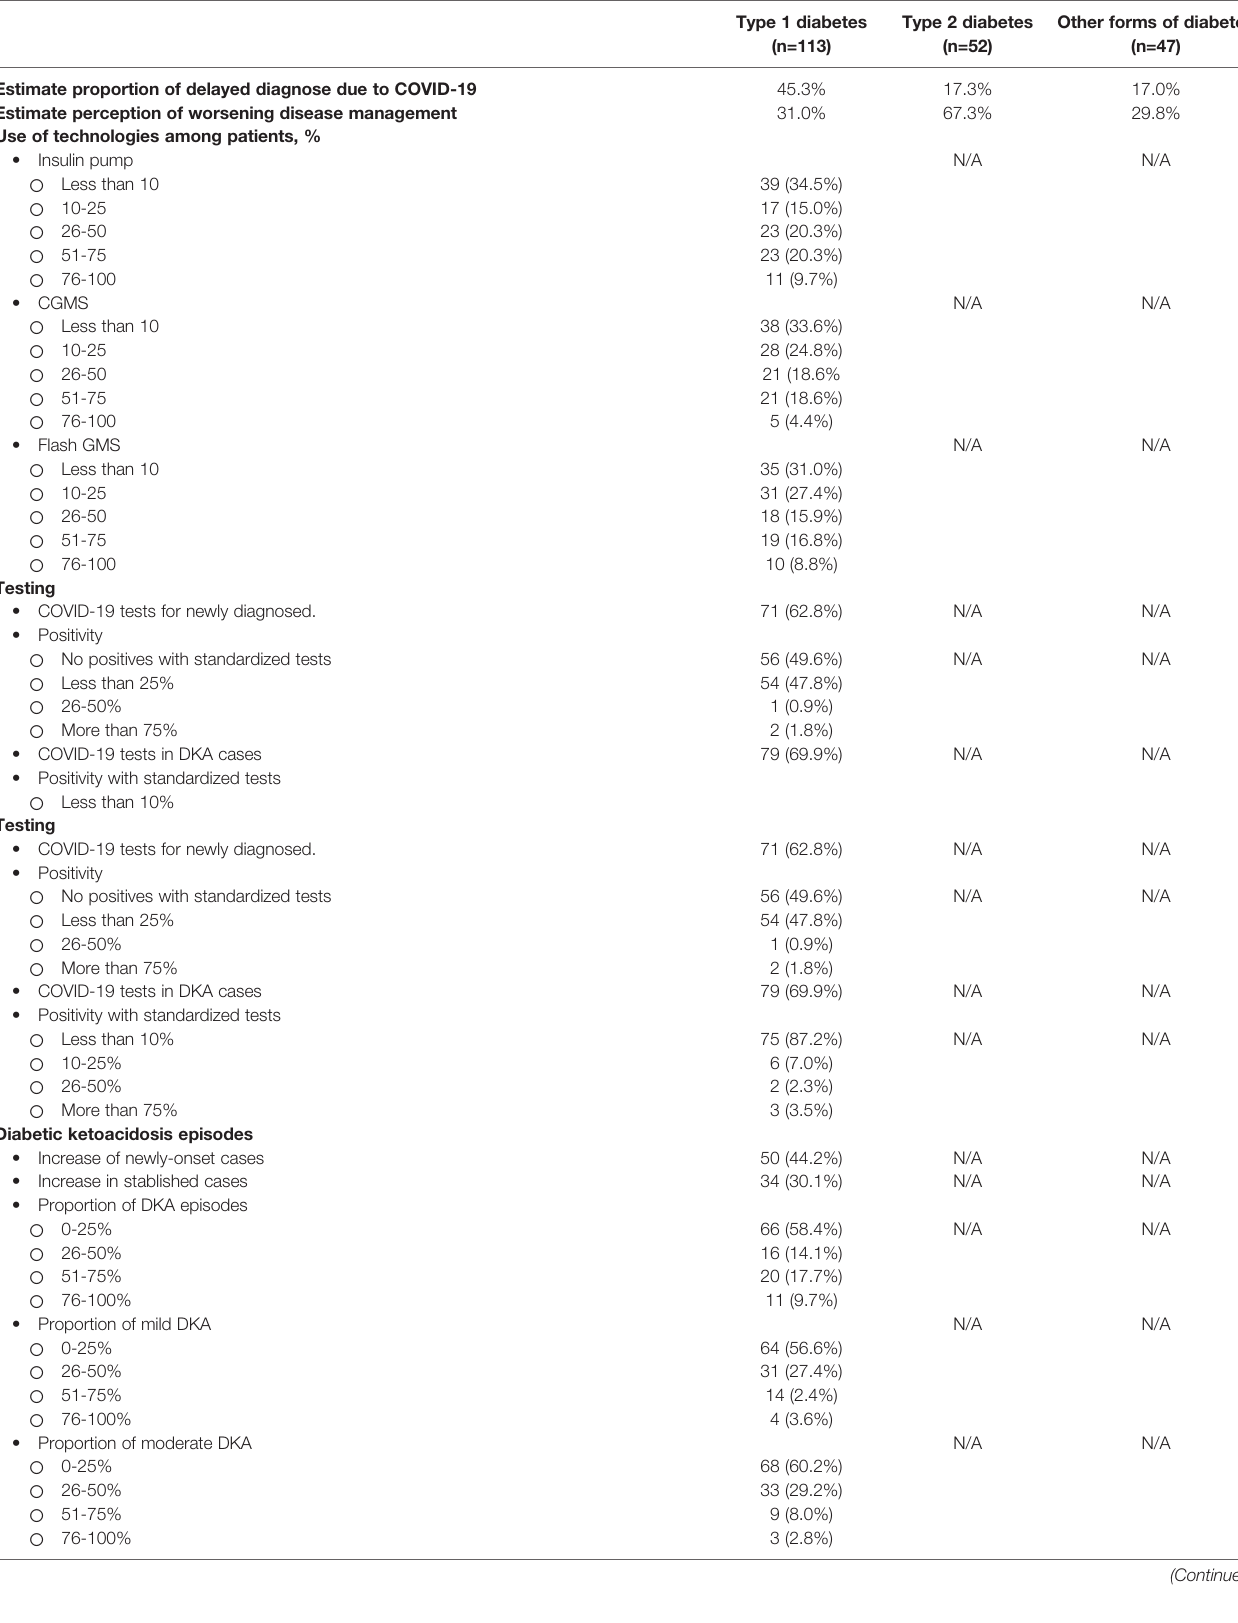
TABLE 2 | Assessment of pediatric diabetes care during the COVID-19 pandemic by clinical